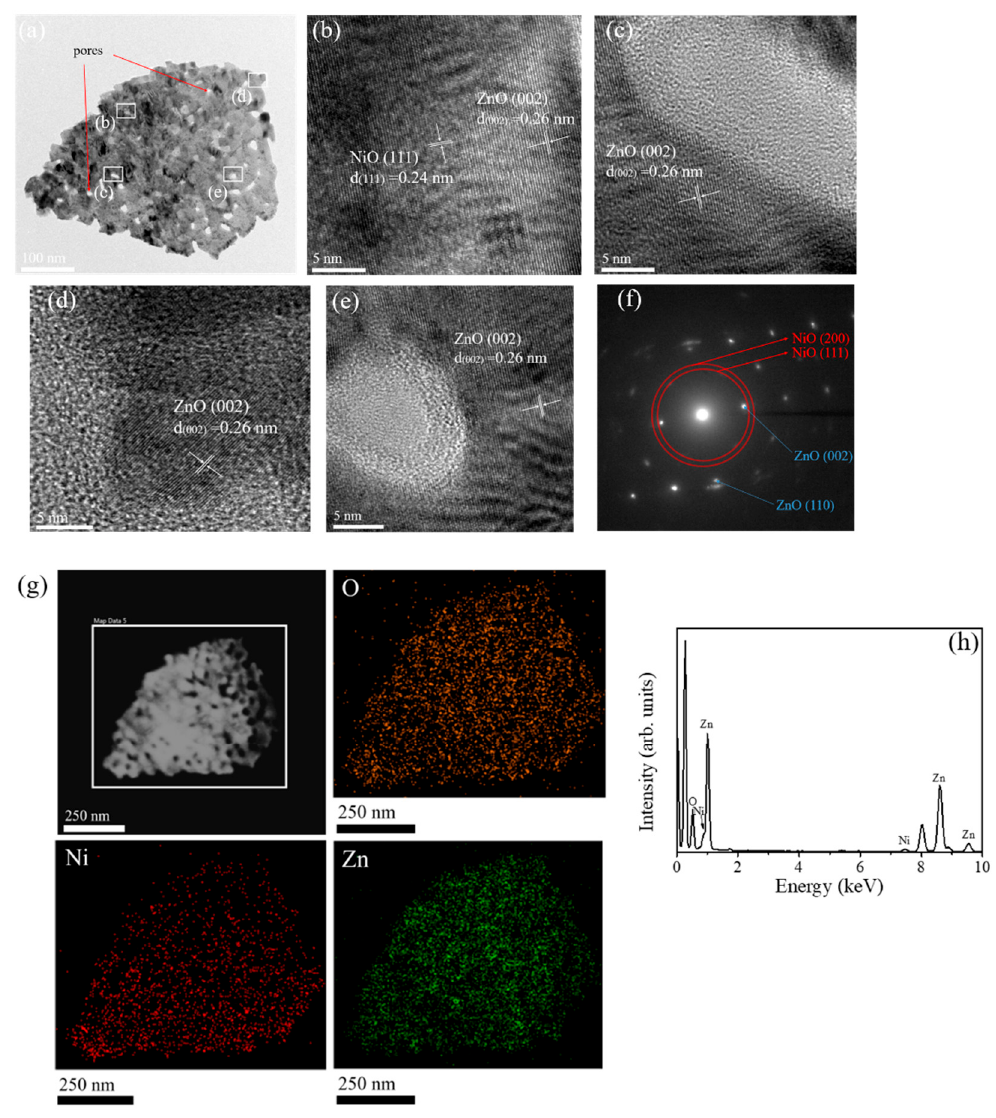
Figure 3. TEM analyses of a single ZnO-NiO-1 composite nanosheet: ( a ) Low-magnification TEM image. ( b – e ) The high-resolution (HR) images taken from various regions of the nanosheet. ( f ) SAED pattern. ( g ) EDS elemental mapping images collected by scanning the white square area and the corresponding elemental mapping images demonstrated that the Zn, Ni, and O were homogeneously distributed over the area of the whole sheet structure. ( h ) EDS spectra of Zn, Ni, and O taken from the ZnO-NiO-1 nanosheet.